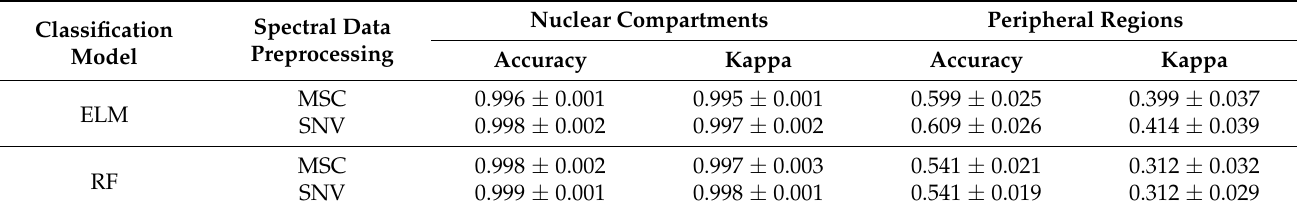
Table 2. SCC staging results based on spectral data from different